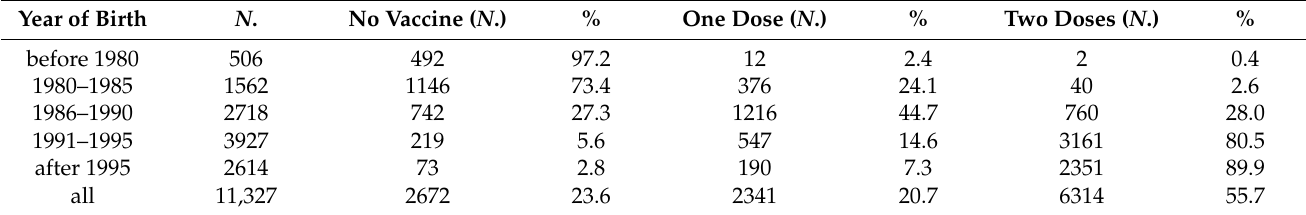
Table 1. Vaccination compliance according to year of birth groups.